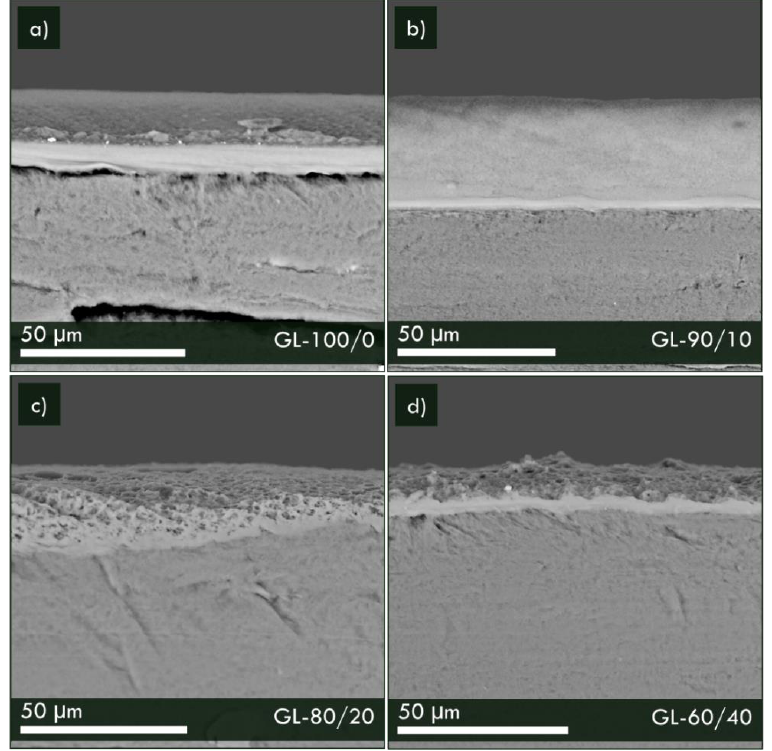
Figure 7 . Detailed SEM micrographs of composite membranes in the cross-sectional direction: ( a ) GL-100/0, ( b ) GL-90/10 ( c ) GL-80/20 and ( d ) GL-60/40 samples.